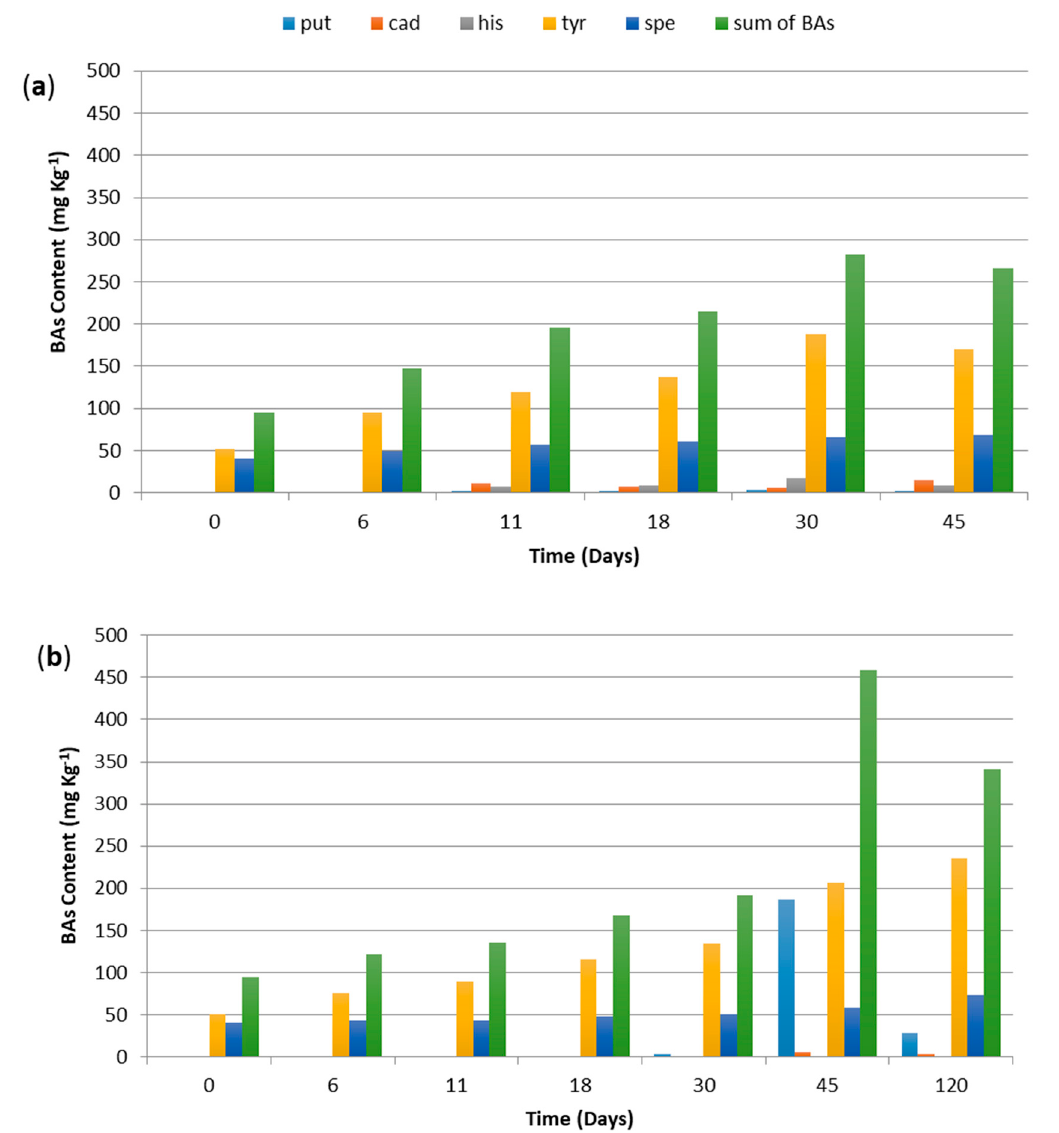
Figure 3. Putrescine (put), cadaverine (cad), histamine (his), tyramine (tyr), spermidine (spd), and sum of biogenic amines (as mg / Kg) content in “ Mortadella di Campotosto ”-like sausages produced with beef (panel ( a ), MCB) and hog (panel ( b ), MCH) casings, over time.